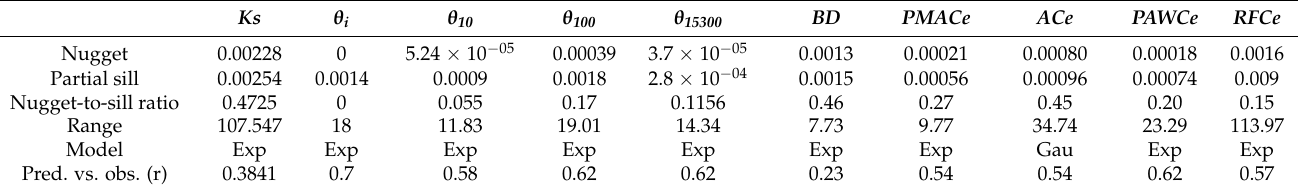
Table 3. Model selected, variogram parameters, nugget-to-sill ratio and cross-validation